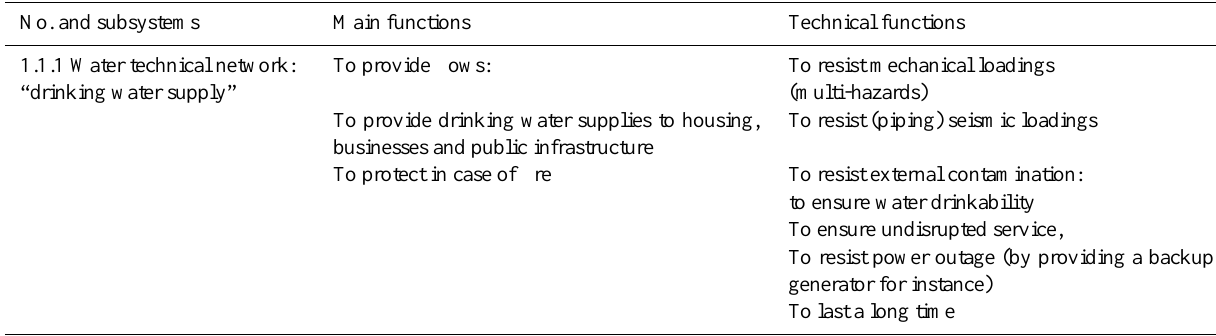
Table 2. Functional analysis table for drinking water supply technical